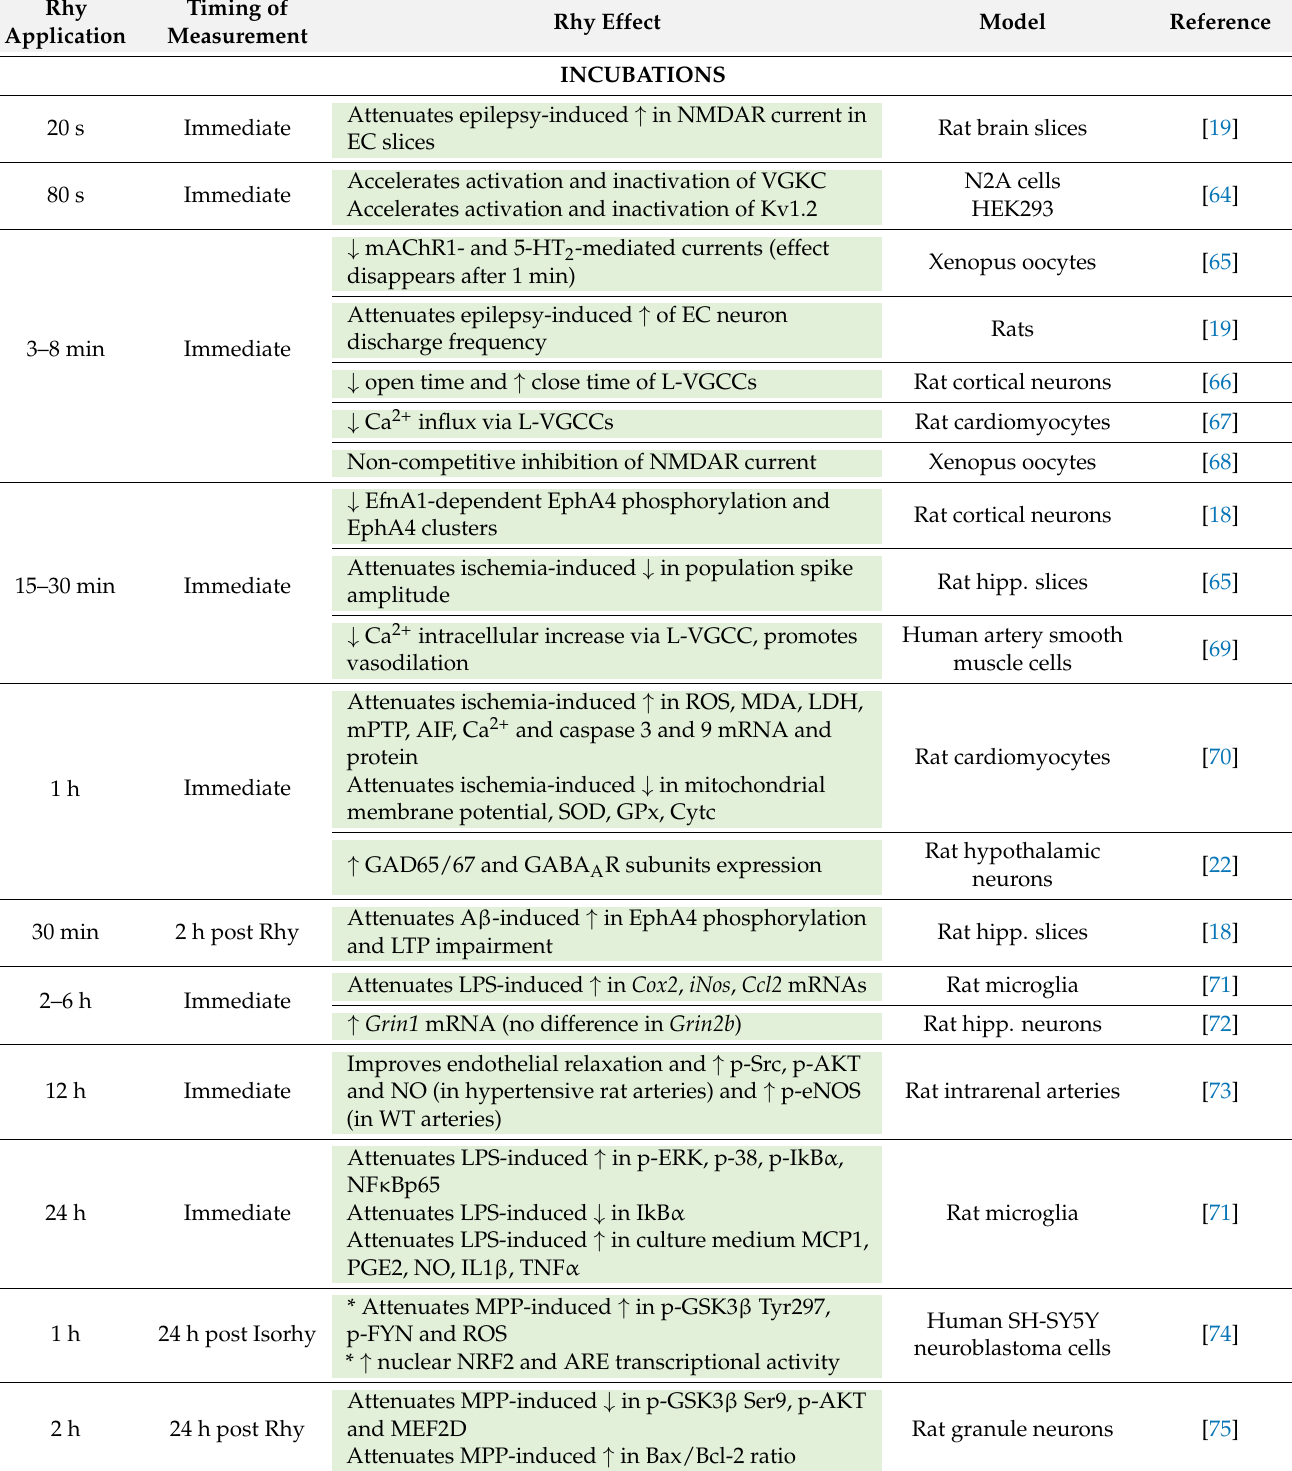
Table 1. Compilation of datasets showing molecular and cellular (and some electrophysiological and behavioral) effects of rhynchophylline (Rhy) organized as a function of treatment type and duration, and by measurement